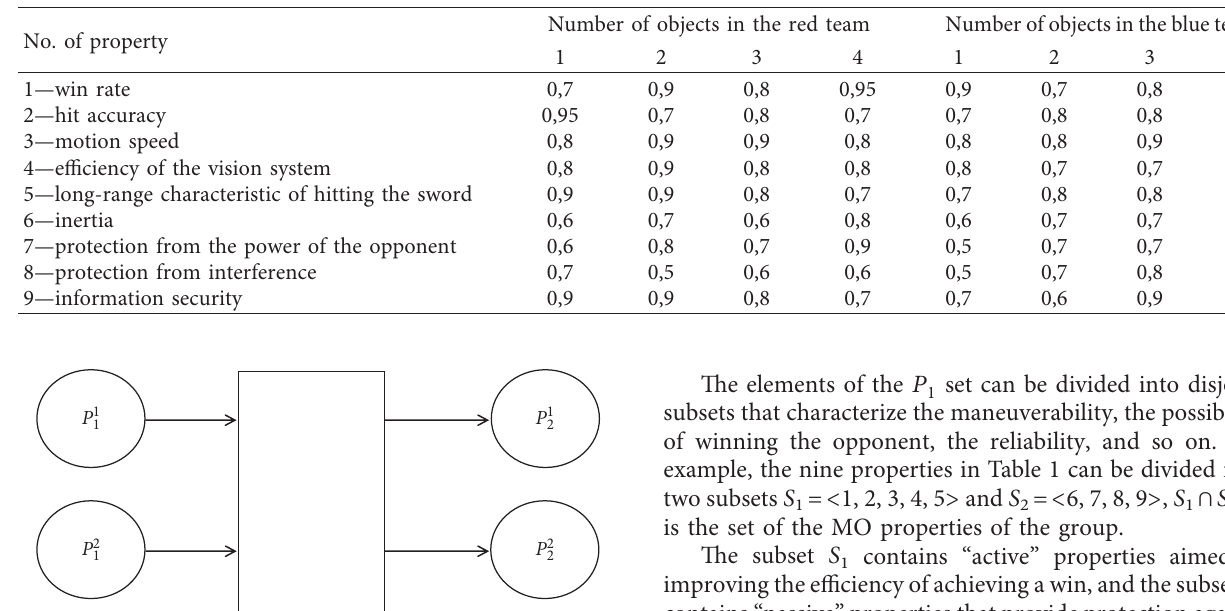
Table 1: Results of expert assignment of membership assessment properties for each mobile object of a red and blue group.